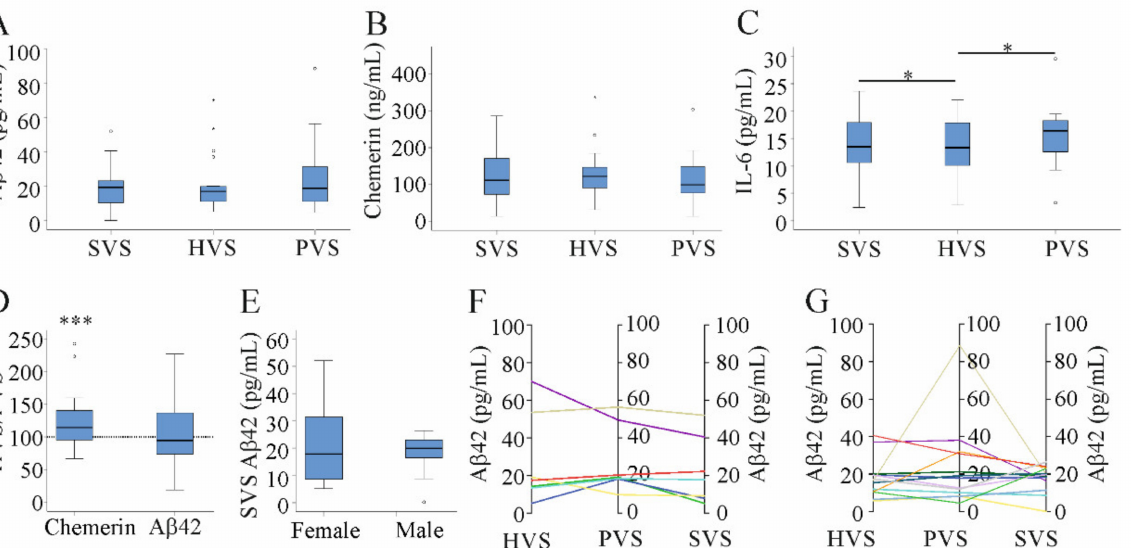
Figure 1. A β 42, chemerin, and IL-6 in serum of patients with liver cirrhosis. ( A ) A β 42, ( B ) chemerin, and ( C ) IL-6 in systemic venous (SVS), hepatic venous (HVS), and portal venous (PVS) serum of patients with liver cirrhosis. ( D ) HVS/PVS ratio of chemerin and A β 42 in %. The dotted line is the 100% value. ( E ) SVS A β 42 in females and males. ( F ) A β 42 in HVS, PVS, and SVS of female and ( G ) male patients. * p < 0.05, *** p <